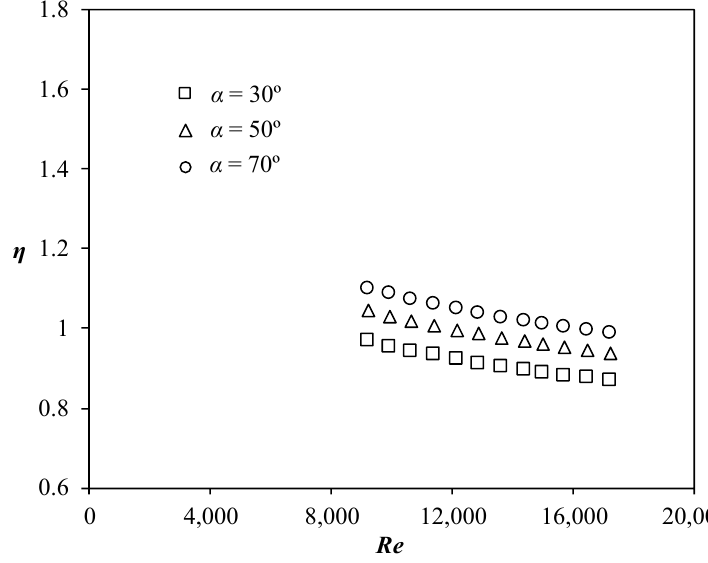
Figure 10. Thermal performance for various attack angles.